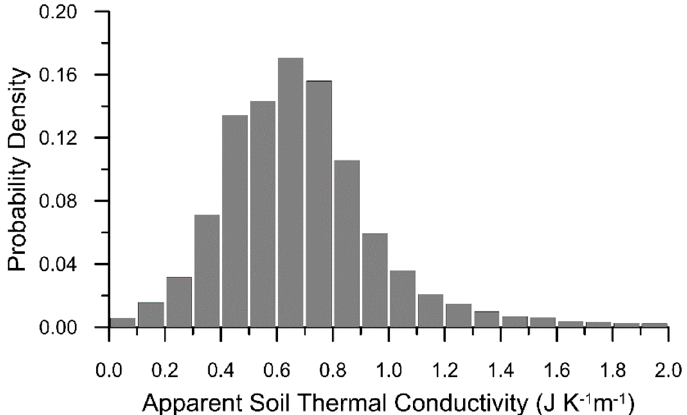
Figure 10. Probability density of soil Apparent Thermal Conductivity at TVGr.